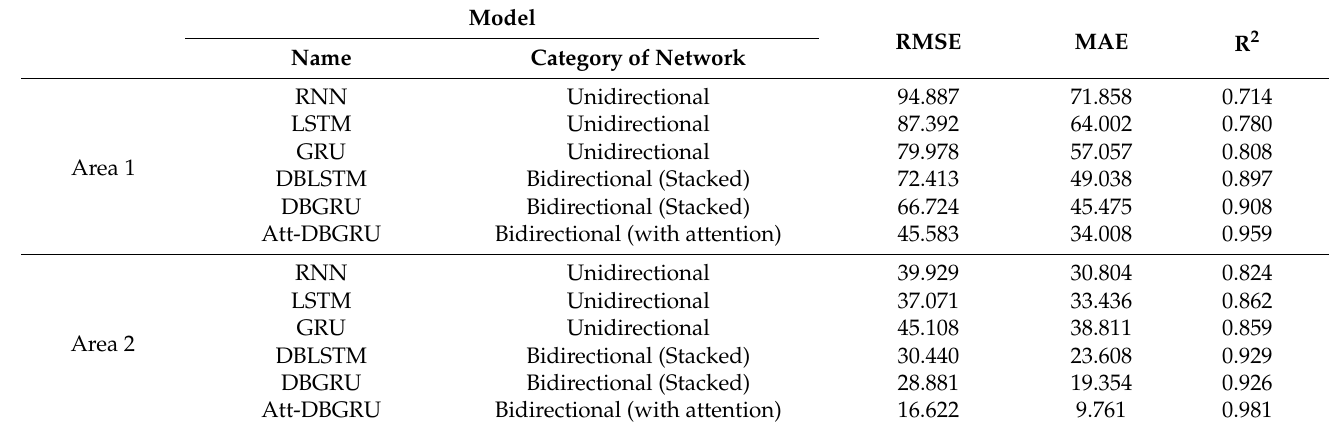
Table 2. Results of the performance evaluations (Area 1 and Area